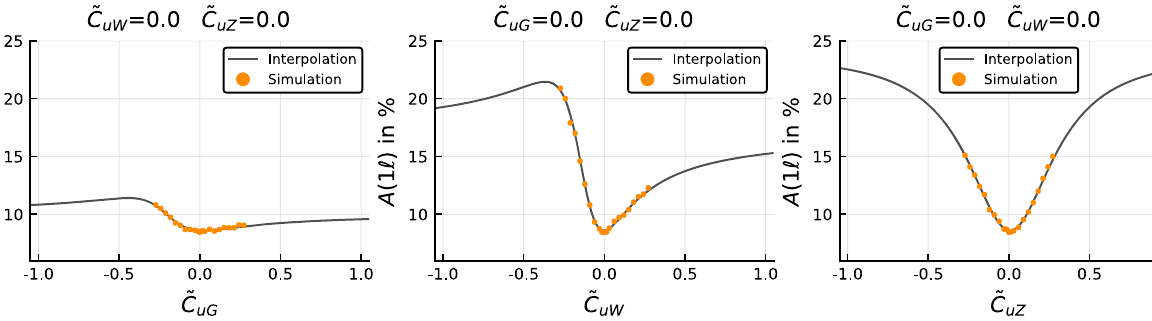
Fig. 4 Sampling points and interpolation result for the t ¯ t γ cross section, represented as slices of the phase space where only one of the Wilson coefficient is varied at a time, while the others are set to zero